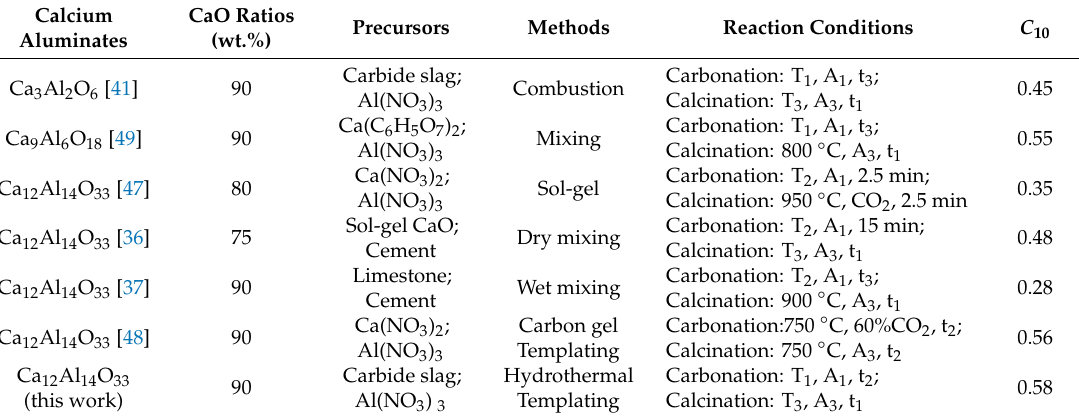
Figure 4. CO 2 capture capacities of sorbents prepared using different methods (glucose addition of 1 mol/L for the hydrothermal template method, pre-calcination at 600 °C for 1 h; carbonation in 15% CO 2 /N 2 at 700 °C for 20 min, calcination in 100% N 2 at 850 °C for 10 min). Table 2. Comparison of CO 2 capture performance for different CaO-based, calcium aluminates-stabilized sorbents.